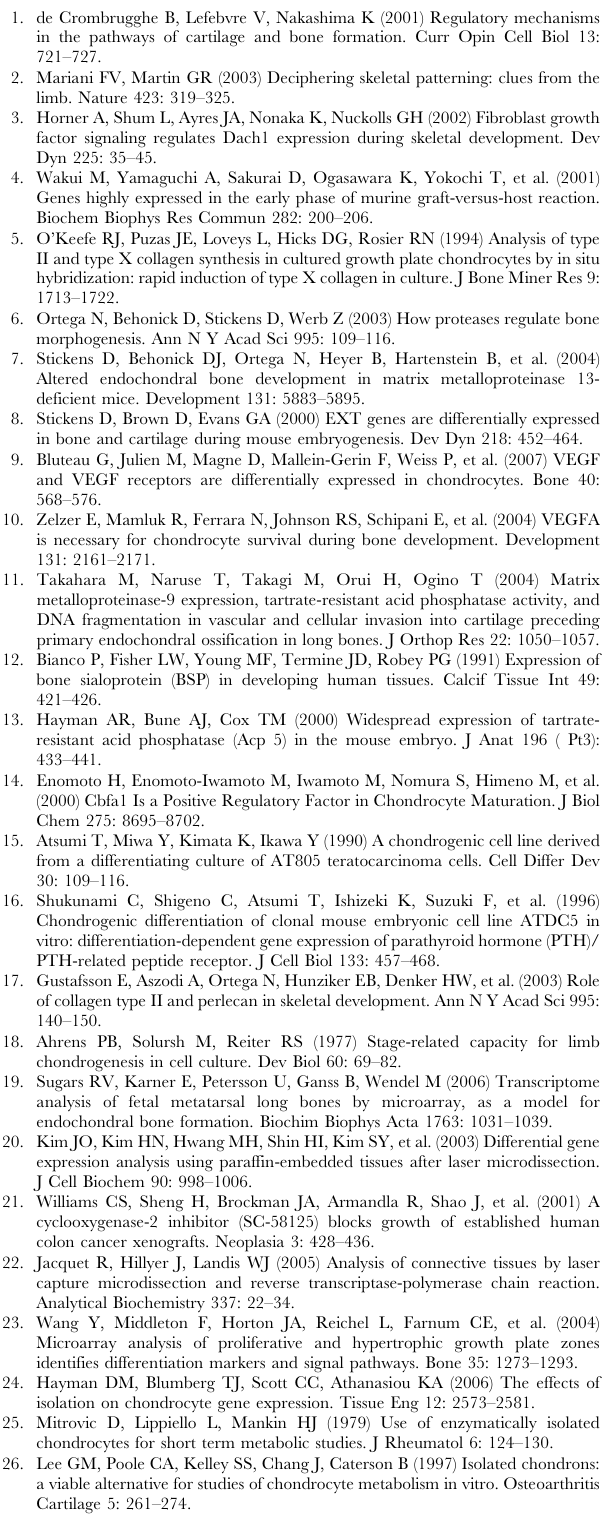
Table S6 GSEA enrichment of micromass culture data using c3 gene